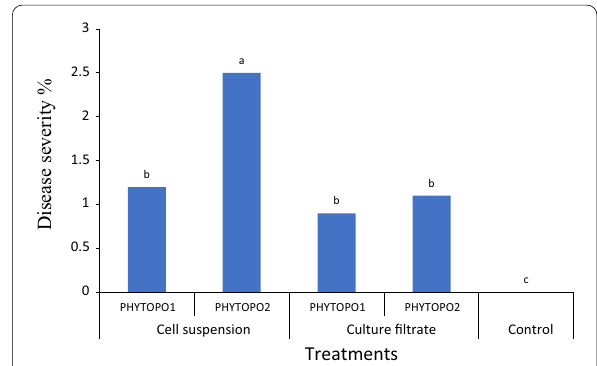
Fig. 3 Disease reduction percentage of treated tomato plants under greenhouse conditions. Columns with the same letters are not significantly different according to Fisher’s protected least significant difference at p 0.05 ≤